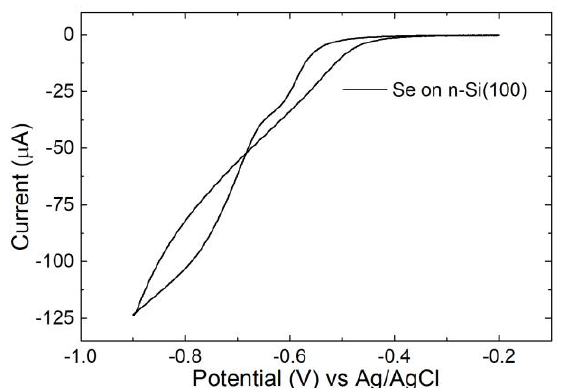
Figure 3. CV of Se(IV) solution on n-Si in sulfuric acid between − 0.2 V to − 0.9 V, scan rate 10 mV / s.